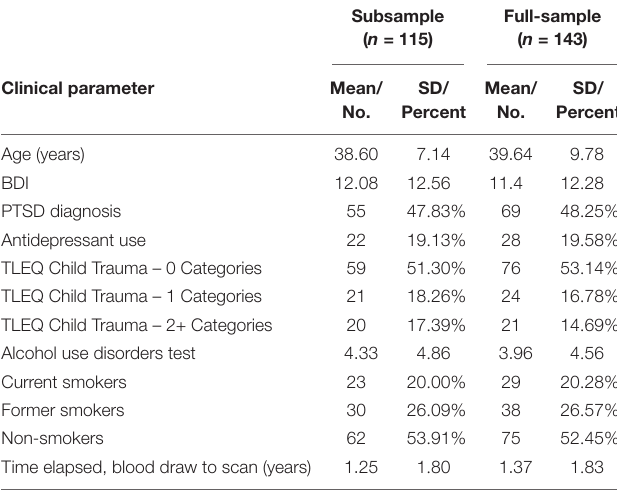
TABLE 1 | Clinical and demographic features of sample.